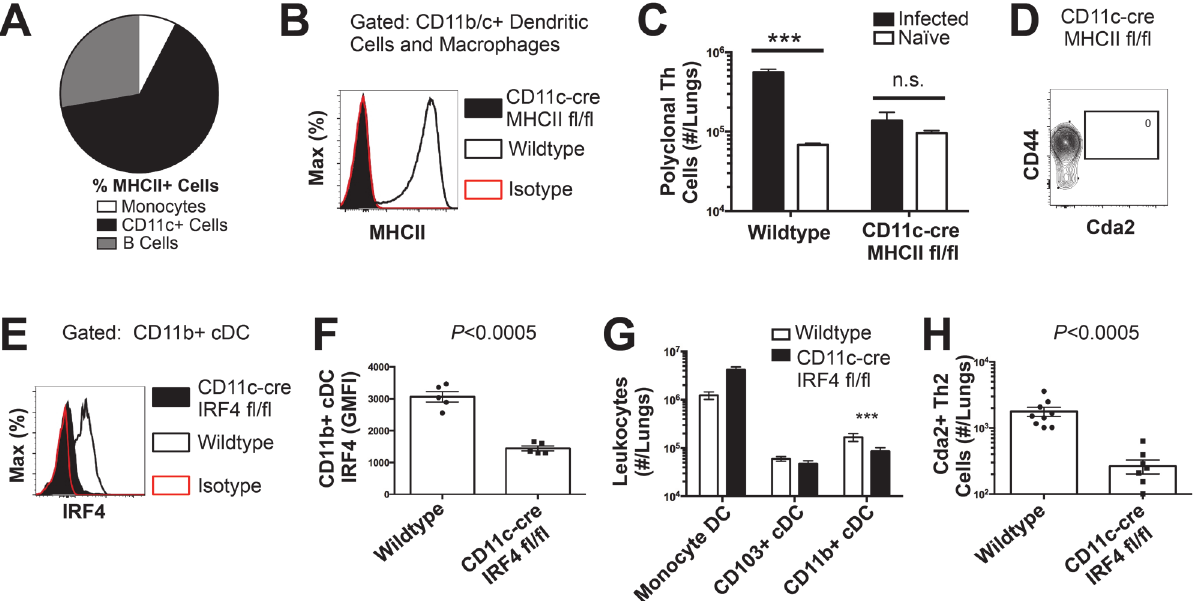
Fig 4. Interferon Regulatory Factor 4-Dependent Conventional Dendritic Cells Coordinate Th2 Cell Induction. (A) Antigen-presenting cells as a proportion of total MHCII+ cells in the lungs of infected mice. (B) MHCII expression by CD11b/c+ cells from mice 14 days post-infection with KN99 α . Isotype refers to CD11b/c+ cells from wildtype mice stained with a rat IgG2b antibody of irrelevant specificity. (C) Quantification of pulmonary CD4+ Foxp3- CD44+ pulmonary Th cells. (D) Biexponential plot of CD4+ Foxp3- cells, indicating the absence of antigen-specific (CD44 − , Cda2 − ) cells in the lungs of CD11c-cre MHCII mice infected with KN99 α . (E) IRF4 expression by CD11b+ cDC from lungs of CD11cre IRF4 fl/fl or wildtype mice 14 days post-infection with KN99 α . Isotype refers to CD11b+ cDC from wildtype mice stained with a rat IgG1 antibody of irrelevant specificity. (F) Geometric mean fluorescence intensity of CD11b+ cDC in from the lungs of infected CD11c-re IRF4 fl/fl mice. (G) Quantification of monocytes and dendritic cell subsets from the lungs of mutant or wildtype mice infected with KN99 α . (H) Quantification of IL-5+ IL-13+ antigen-specific Th2 cells contained in the lungs of mutant or wildtype mice 14 days post-infection with KN99 α . Data are presented as mean +/- standard error. * = P < 0.05, *** = P < 0.0005, and n.s. = not significant by Mann-Whitney U . Cda = chitin deacetylase, Flt3L = fms-like tyrosine kinase 3 ligand, MHC = major histocompatibility complex, cDC = conventional dendritic cells, IRF4 = interferon regulatory factor